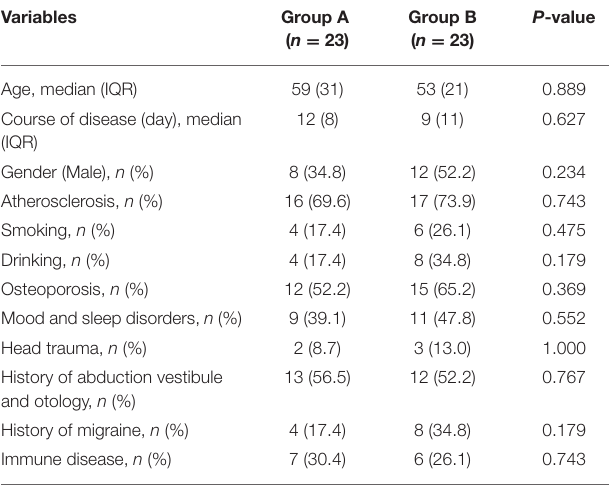
TABLE 1 | General condition of